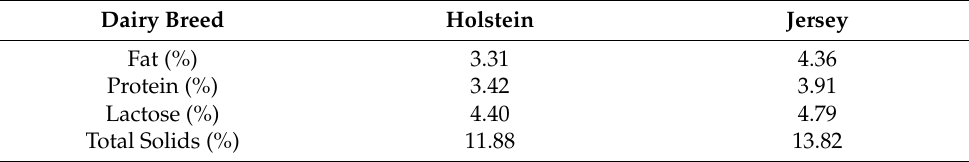
Table 1. Descriptive data on the composition of Jersey and Holstein cow’s milk. Dairy